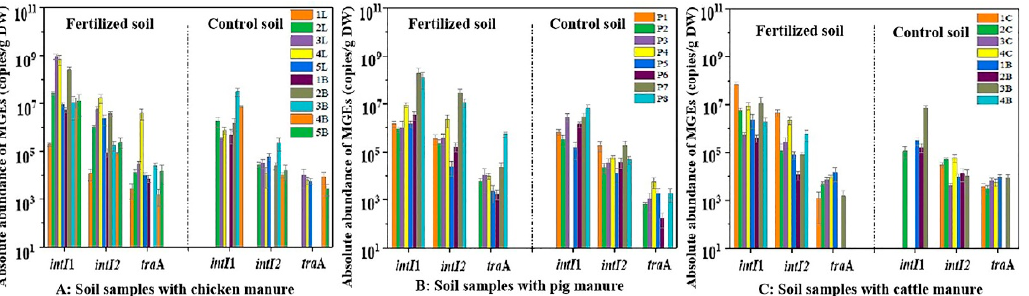
Figure 8. The absolute abundance of MGEs in soil samples applied with livestock manure of family farms.